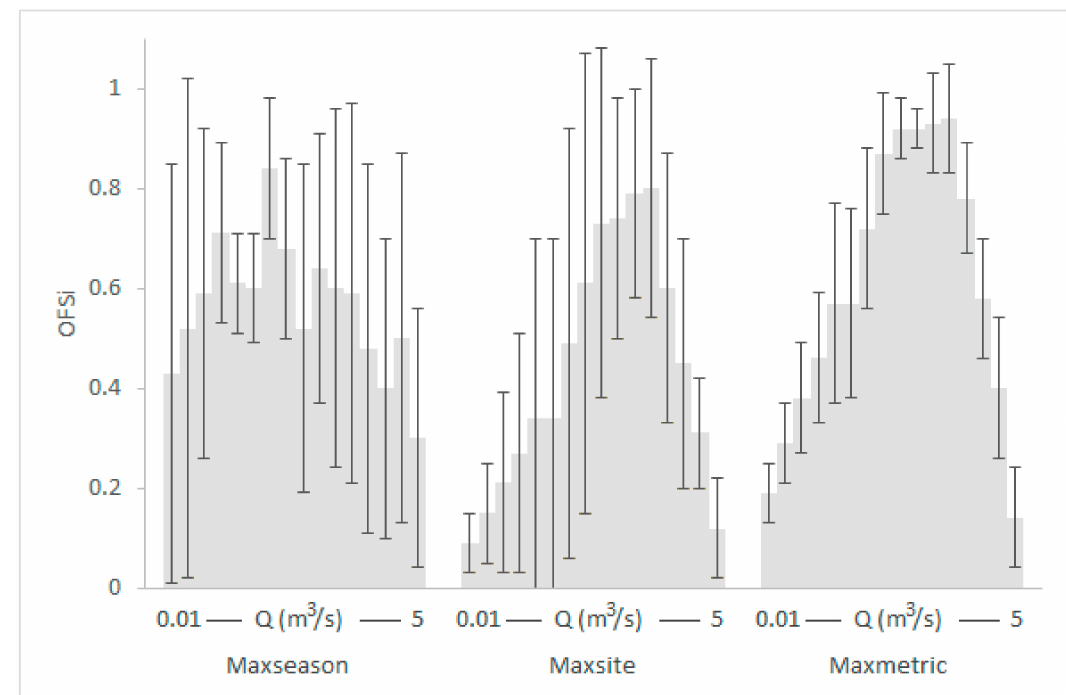
Figure 7. Graphical representation of the seasonal OFS means (gray shaded) and standard deviations within the various κ -normalization alternatives for the Oinoi reach. The OFS values of spring, summer and autumn for each discharge (Q) have been averaged.